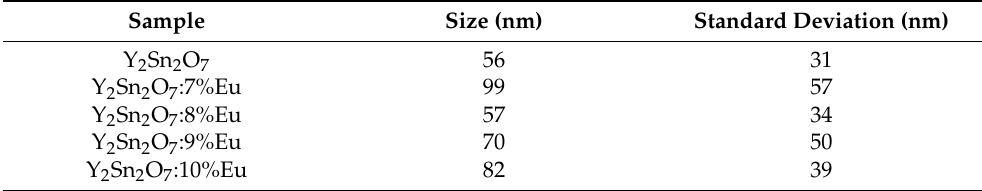
Figure 2. SEM image of 10%Eu: Y 2 Sn 2 O 7 nanoparticles. Table 3. Measured length of the